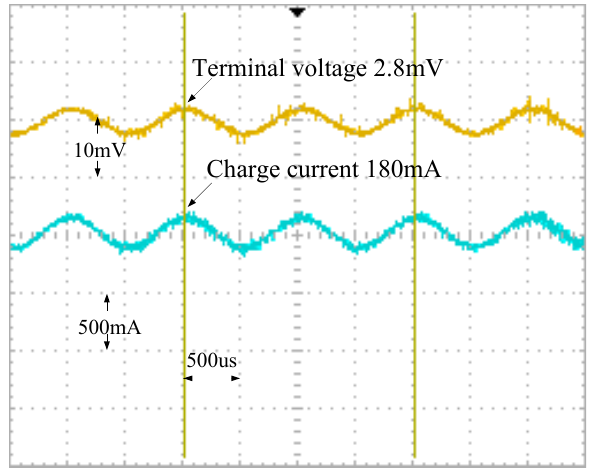
Figure 21. The charge current and the terminal voltage waveforms with DC components filtered at an SOC of 100%.